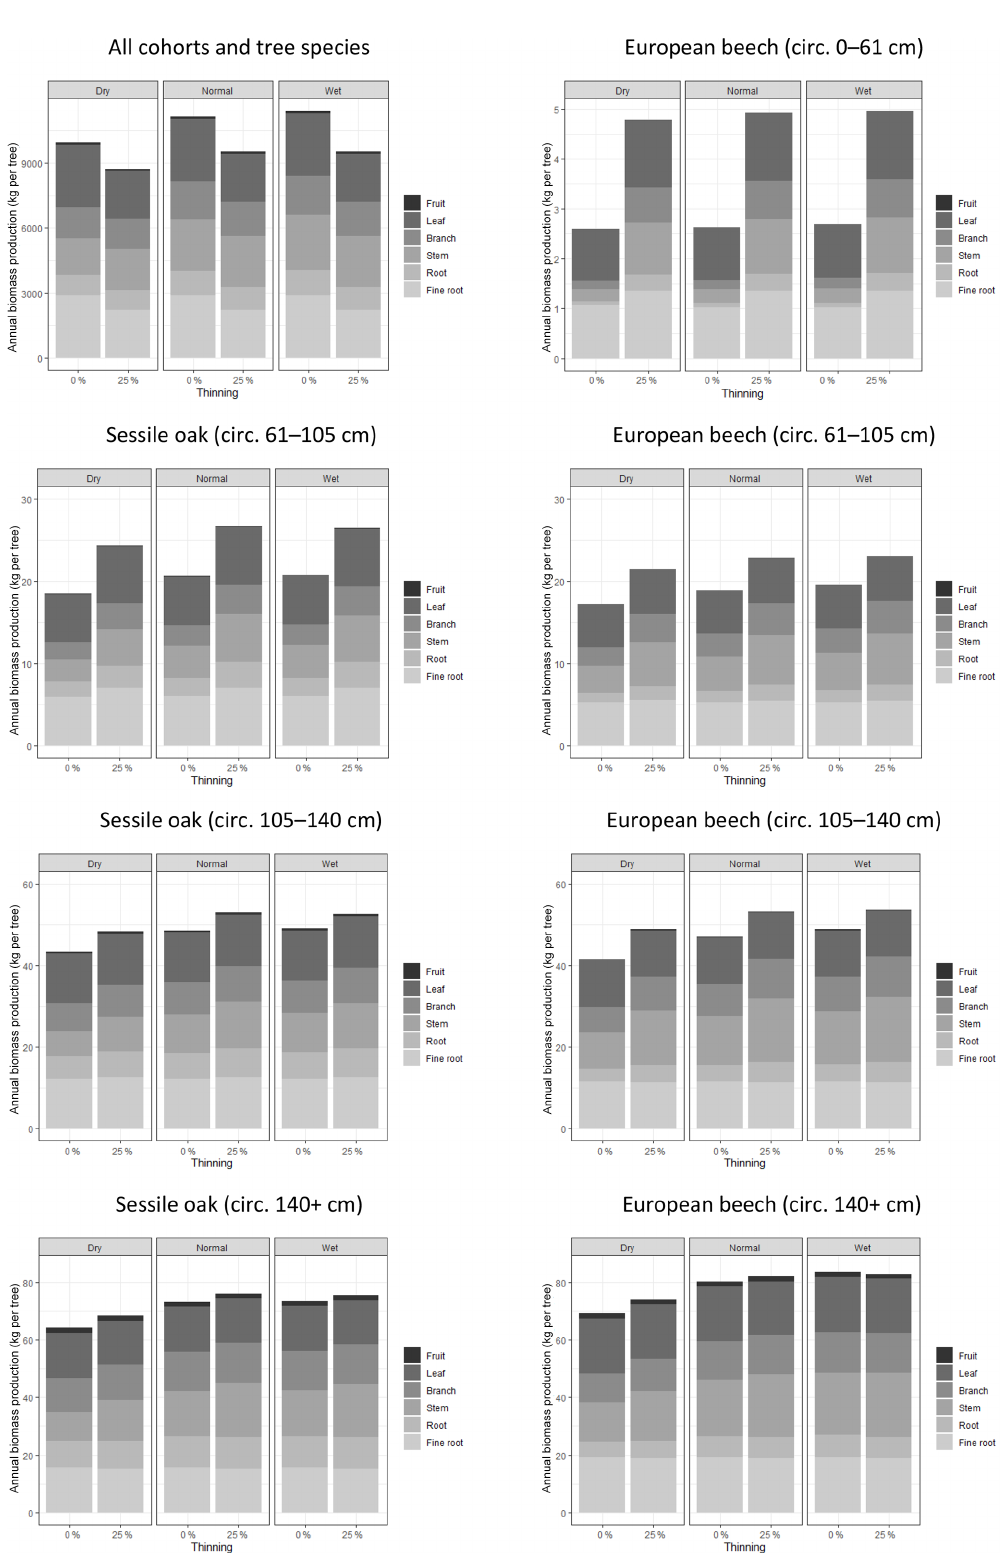
Figure 5. Effects of climate conditions and thinning on biomass production and its allocation to tree compartment in the mixed stand in Baileux. The data used to make these graphs were obtained by simulations using the following options: photosynthesis model of CASTANEA, npp to gpp ratio and distance-independent crown